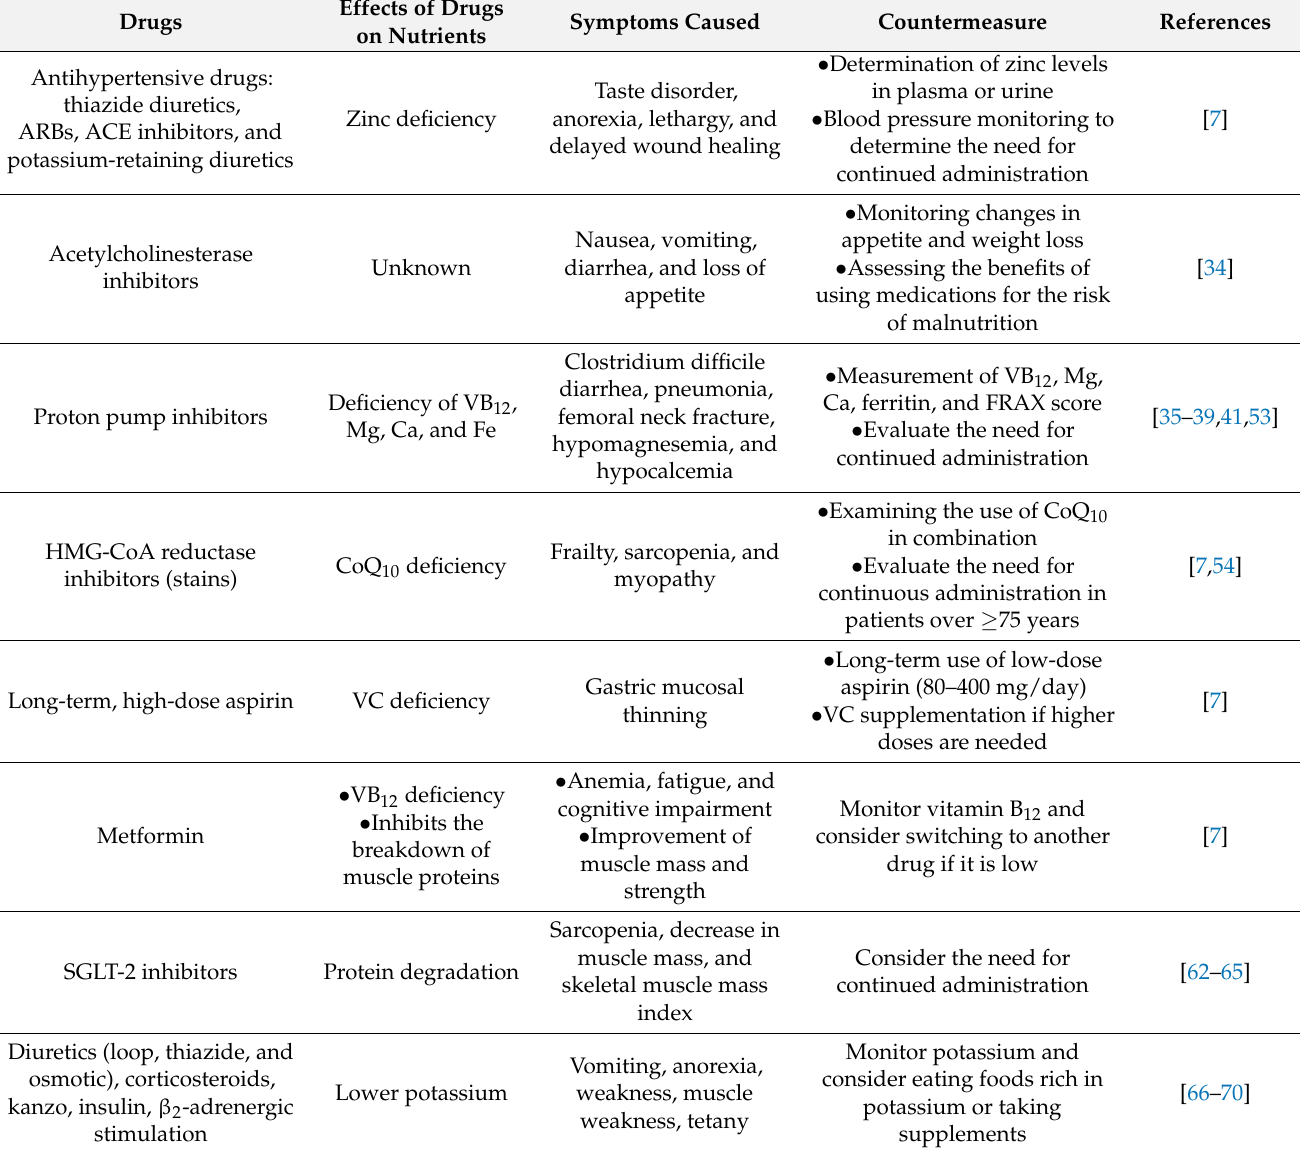
Table 1. Effects of drugs on